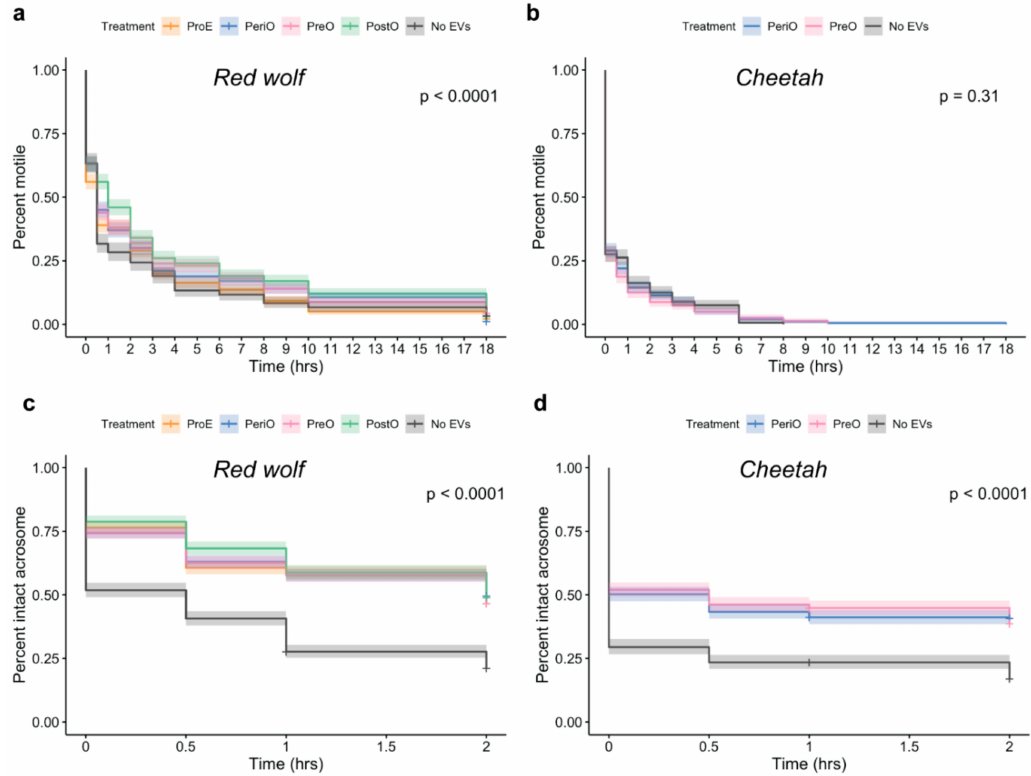
Figure 4. Total motility and acrosome integrity of red wolf and cheetah sperm thawed in the presence or absence (no EVs) of dog and cat oEVs, respectively, collected at di ff erent reproductive stages. In ( a ), post-thaw motility data of red wolf and in ( b ) of cheetah sperm analyzed at 0, 0.5, 1, 2, 3, 4, 6, 8, 10 and 18 h of incubation. Acrosome integrity of red wolf ( c ) and cheetah ( d ) sperm was evaluated at 0, 0.5, 1 and 2 h after thawing. All data are presented as point estimate ± 95% confidence interval. ProE = proestrus; PreO = pre-ovulatory; PeriO = peri-ovulatory; PostO =